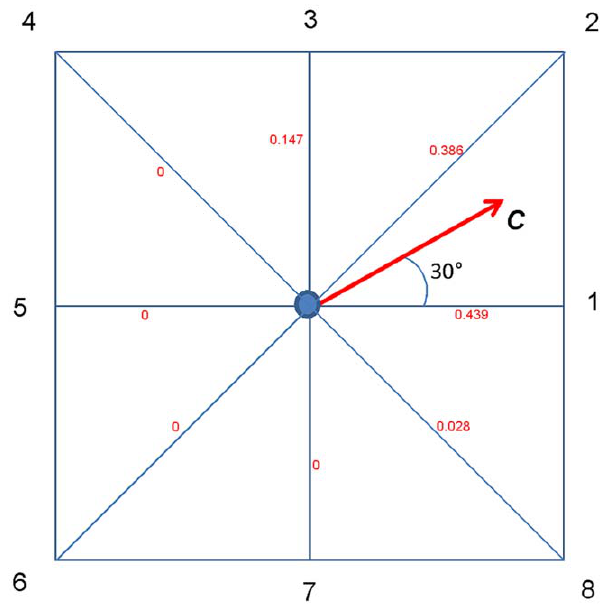
Figure 2. Chemotactic jump probabilities on a 2D lattice. In the simplified 2D case there are eight possible jump directions. For illustration purposes the jump probabilities have been computed for the example of a chemotactic attraction vector oriented at 30 u from the x-axis, i.e. C =(0.866, 0.5). The figure indicates for each jump direction, i =1,.8, the associated chemotaxis-only probability p c ( i ) of the jump (see Table 2).